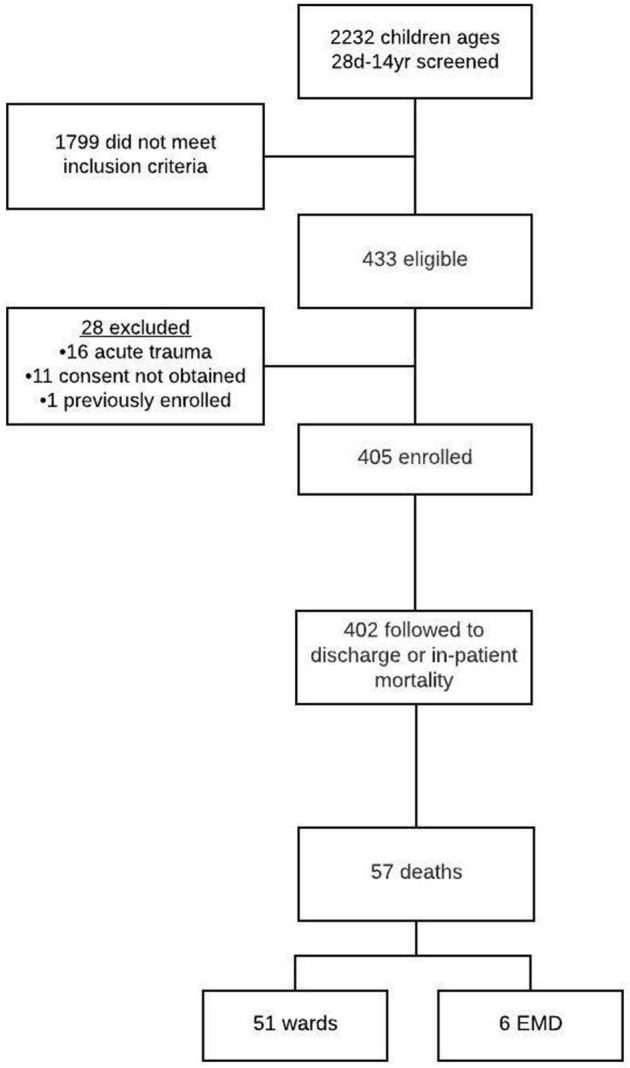
Patient screening, enrollment, and outcomes flowchart.